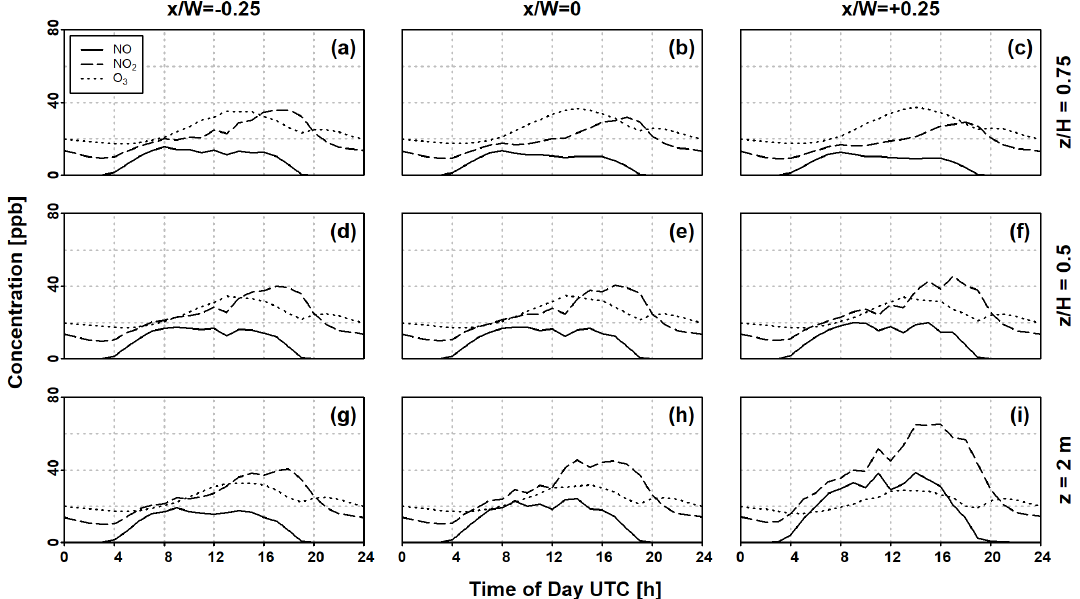
Figure 12. Hourly averaged time series of NO, NO 2 , and O 3 concentrations at (a–c) z/H = 0 . 75, (d–f) z/H = 0 . 5, and (g–i) z = 2m at different horizontal stations over a 24h period. The solar zenith angle ( χ ) crosses the 90 ◦ threshold at 02:35 and